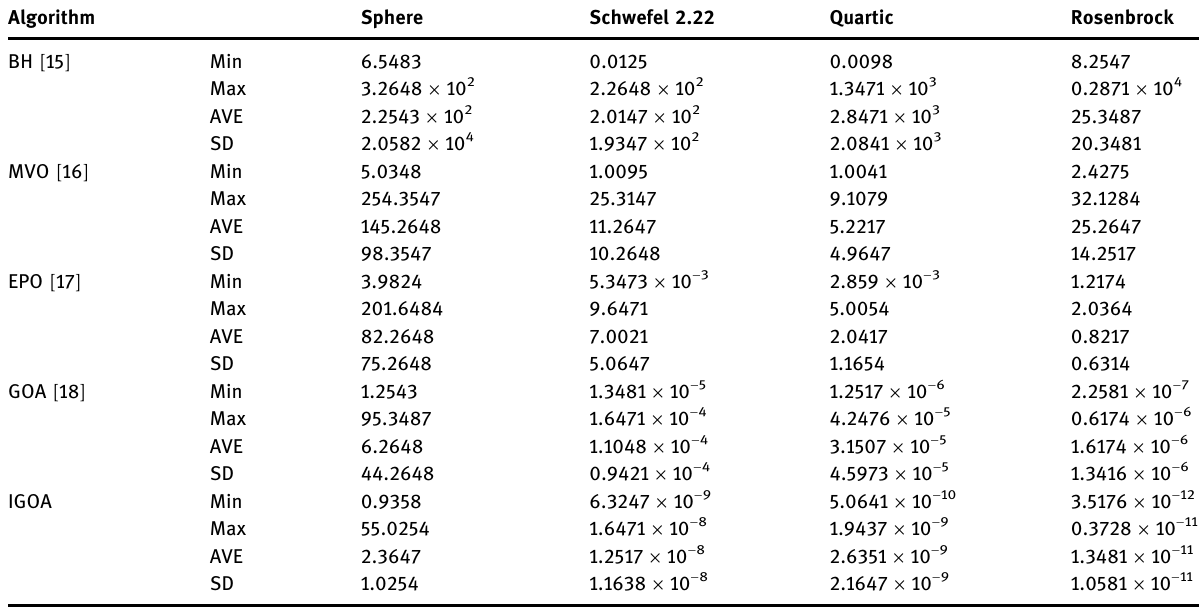
Table 2: The simulation results of the suggested improved GOA compared with other studied algorithms